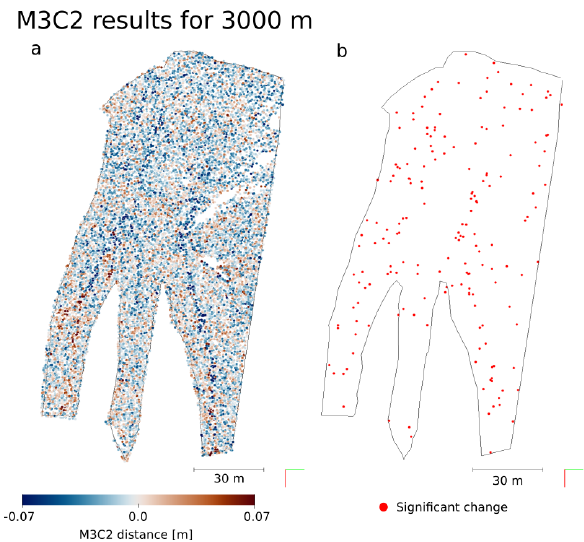
Figure 6. M3C2 point cloud result for 3000 m flight altitude after 5 days. a) M3C2 point cloud distances, b) significant